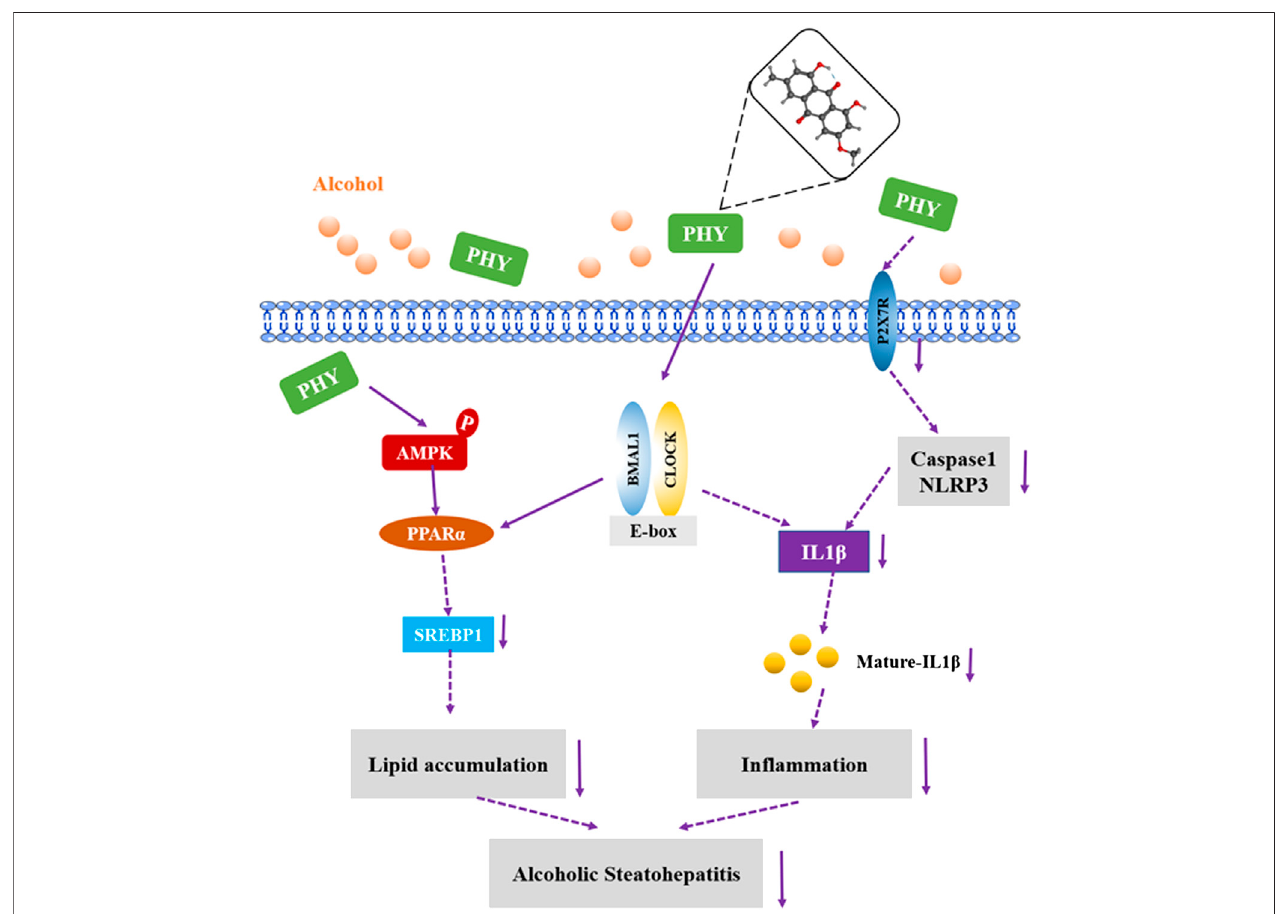
FIGURE 9 | Possible mechanism(s) of suppression of alcoholic hepatosteatosis by physcion. Activation of AMPK-PPAR α signaling and inhibition of P2X7R-IL-l β in fl ammasome by physcion might be mediated by circadian clock pathway.